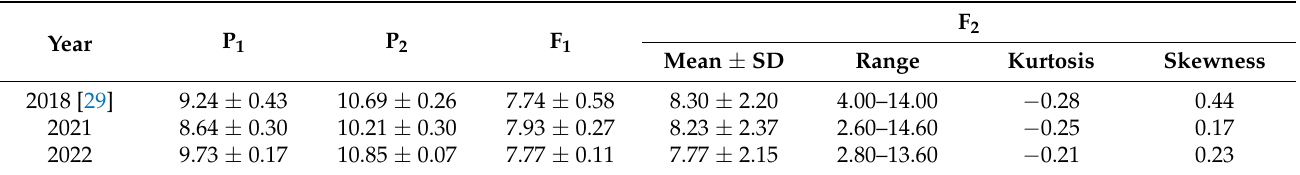
Table 2. Mean ± standard deviation (SD) and range of SSC (%) in the P 1 , P 2 , F 1 , and F 2 generations over three